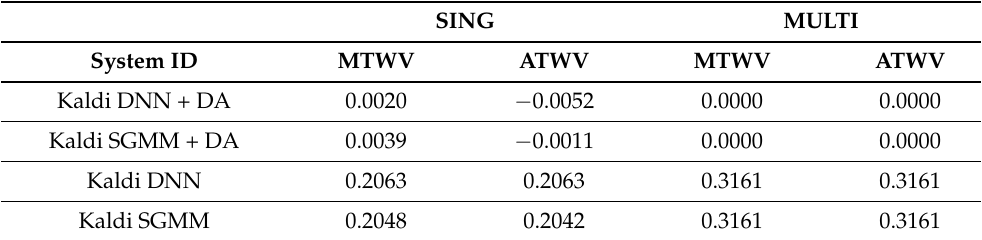
Table 22. System results of the STD task for RTVE test data for single-word (SING) and multi-word (MULTI)